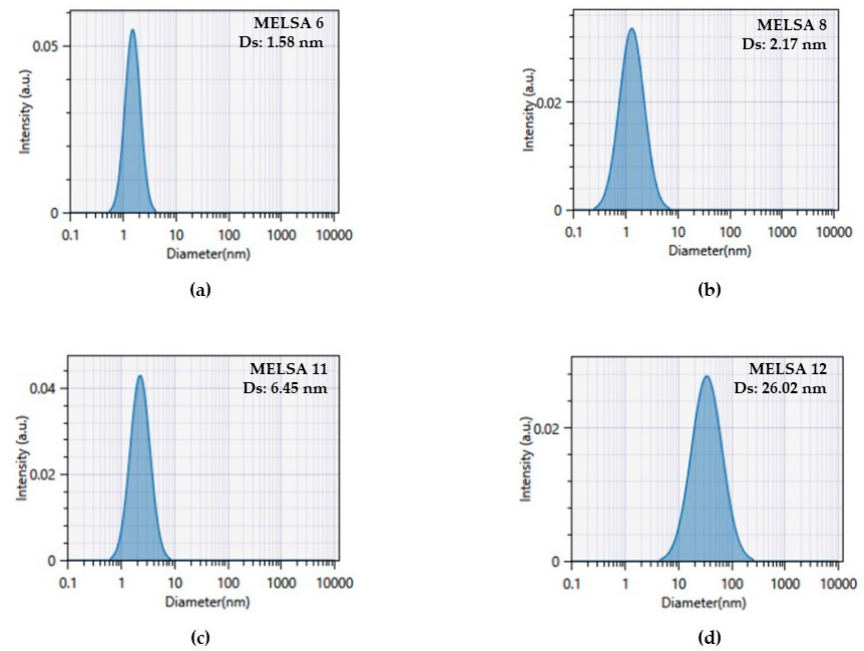
Figure 6. Cumulant profiles of scattering intensity as function of droplet size for the most represen- tative systems emphasized in optimization process: ( a ) MELSA 6, ( b ) MELSA 8, ( c ) MELSA 11 and ( d ) MELSA 12.